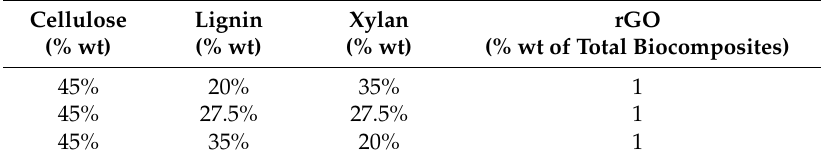
Table 1. Experimental conditions of regenerated film concentrations of lignin, cellulose, xylan and rGO.